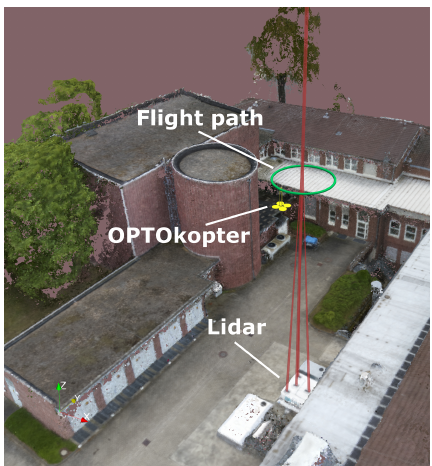
Figure 12. Measurement site of the PTB lidar reference. This 3- D model of the location was calculated using photogrammetry with image data that were captured during the wind measurement